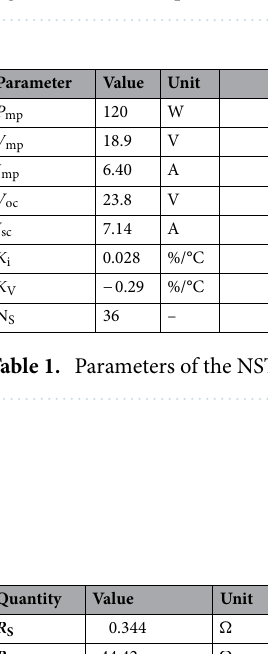
Figure 3. Extracted parameters of the NST-120 panel.